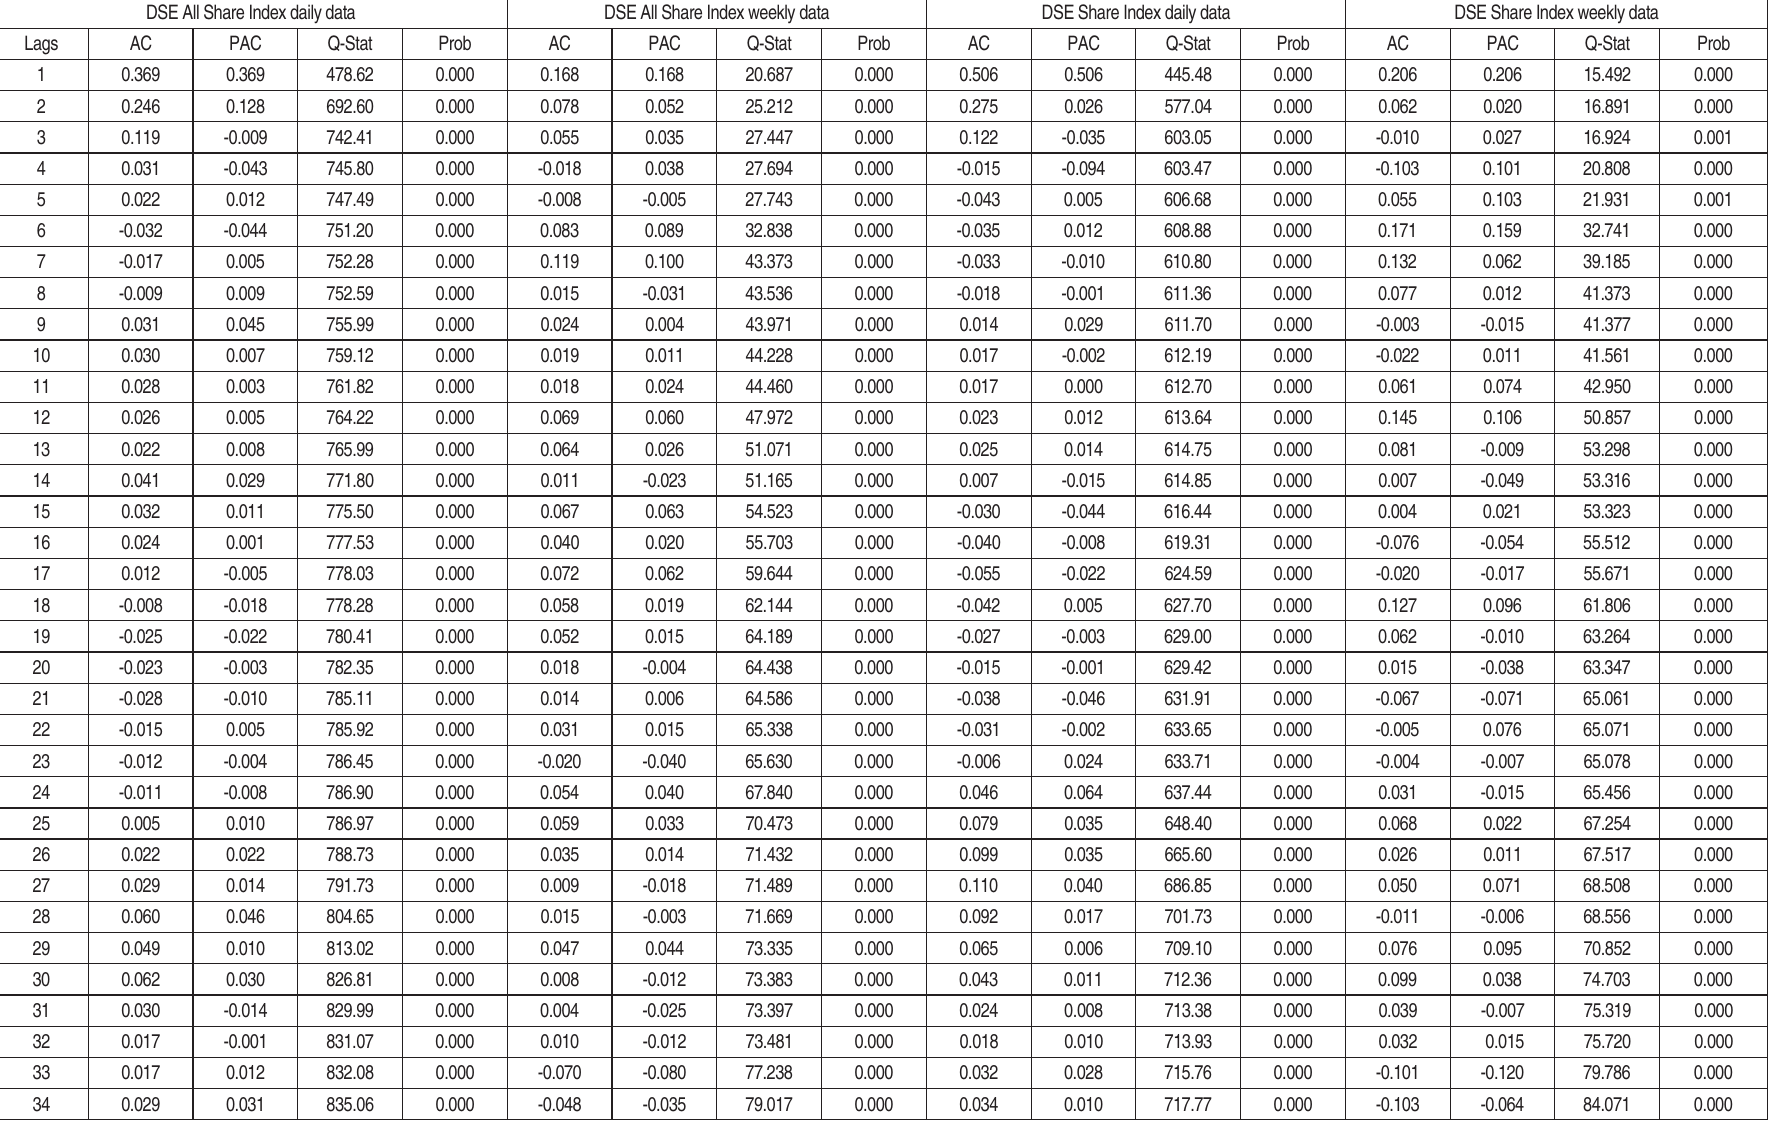
Table 2. Results of the serial correlation